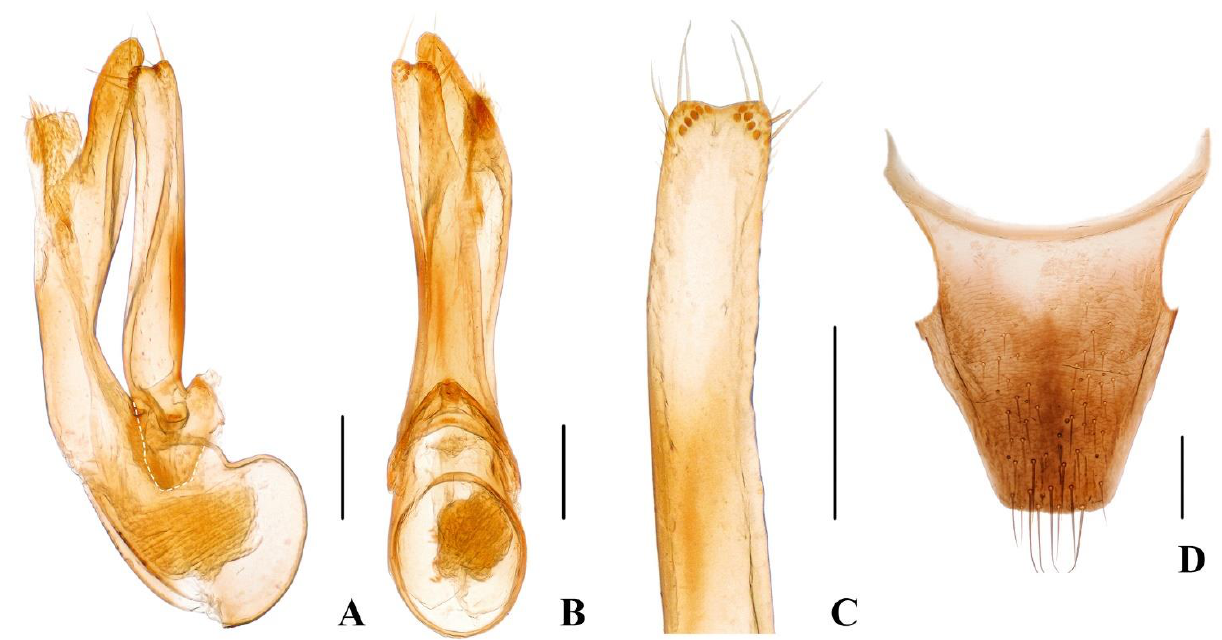
Figure 3. ( A – D ) Diagnostic characteristics of Hesperoschema . ( A – C ) Hesperoschema xuwangi . ( A , B ) Aedeagus, lateral ( A ) and ventral ( B ) views; ( C ) paramere; ( D ) female abdominal tergite X of H. opacum . Scale bars = 0.2 mm.